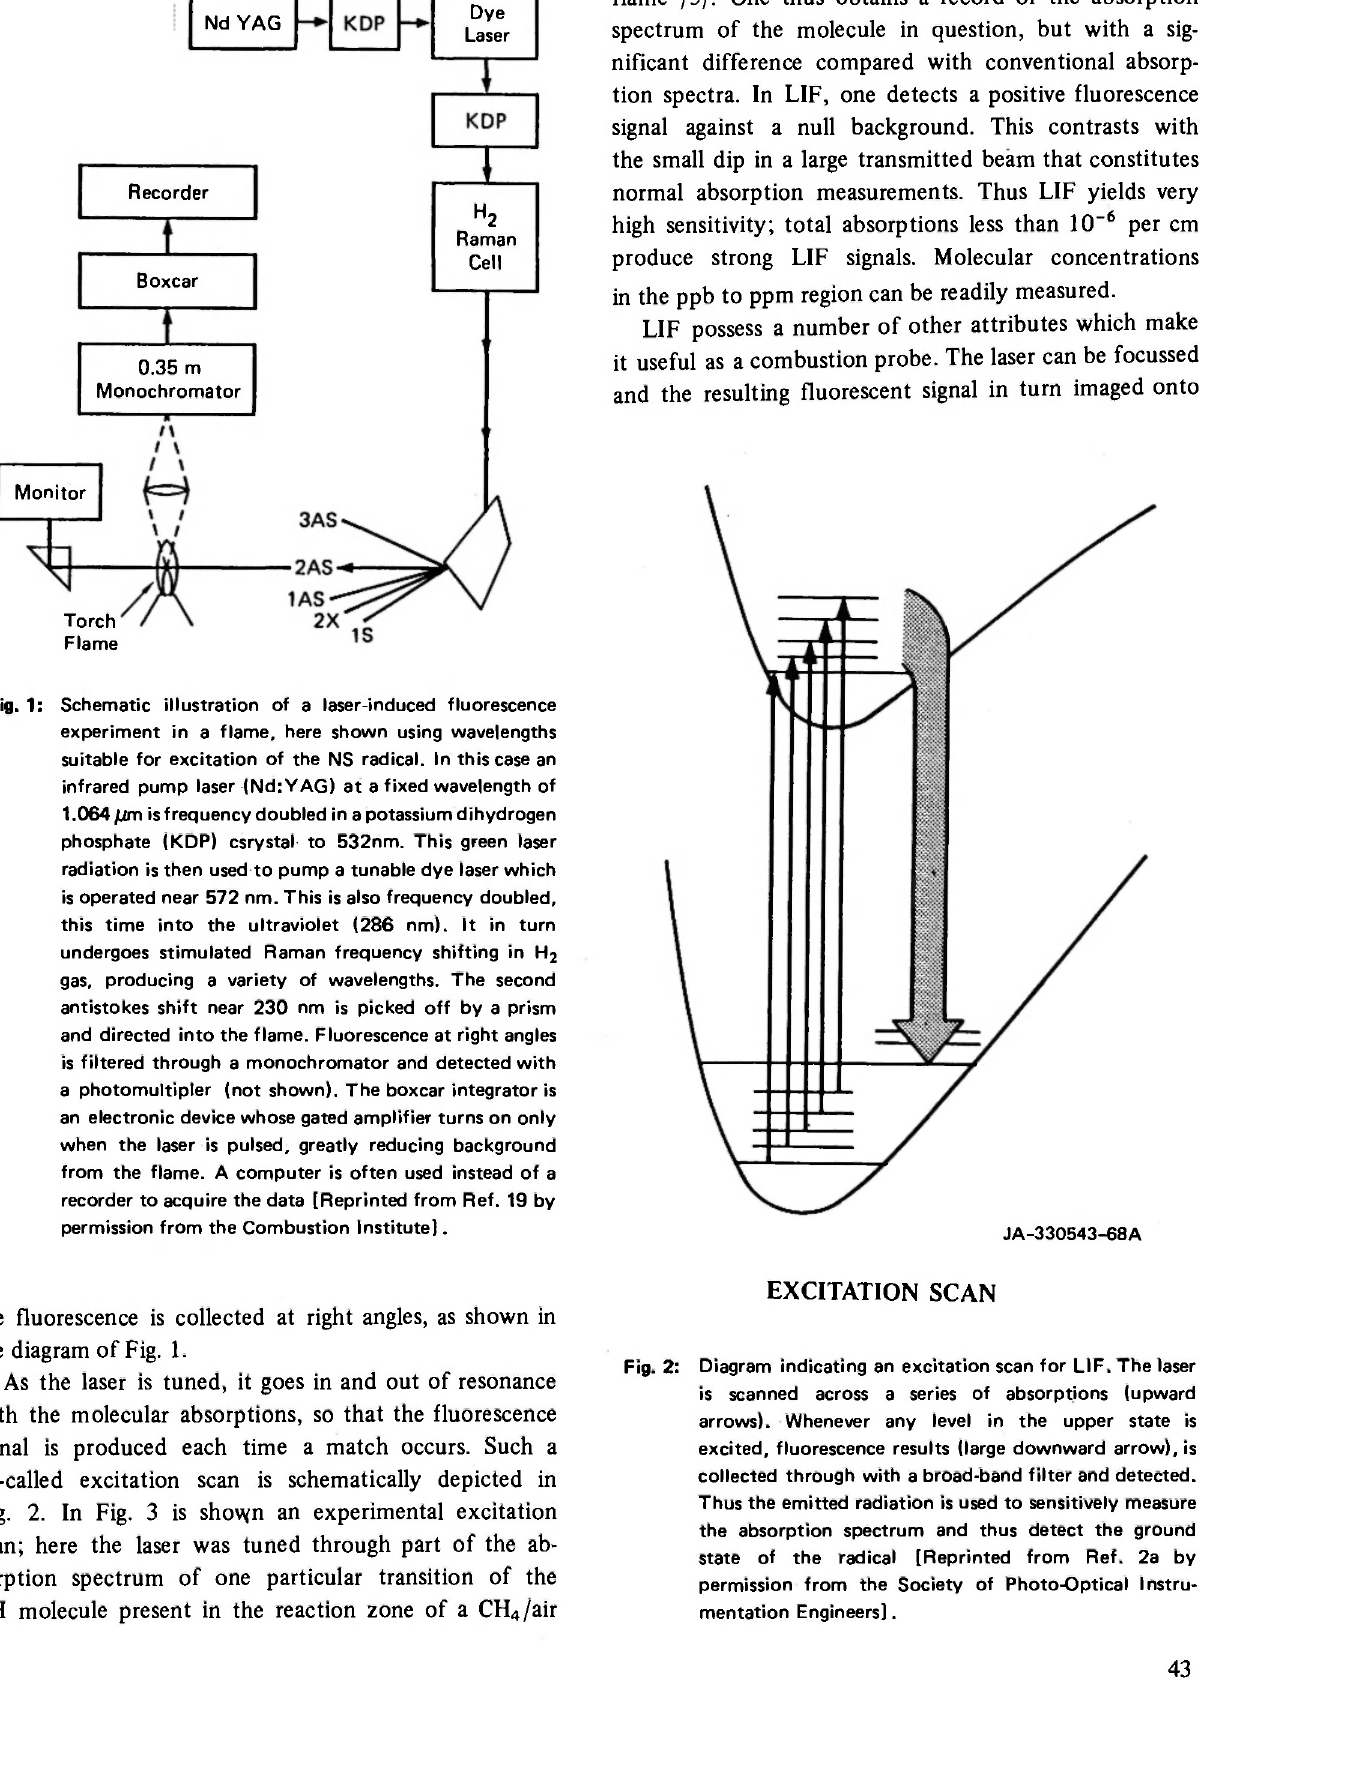
Fig. 1: Schematic illustration of a laser-induced fluorescence experiment in a flame, here shown using wavelengths suitable for excitation of the NS radical. In this case an infrared pump laser (Nd:YAG) at a fixed wavelength of 1.064 μτη is frequency doubled in a potassium dihydrogen phosphate (KDP) csrystal to 532nm. This green laser radiation is then used to pump a tunable dye laser which is operated near 572 nm. This is also frequency doubled, this time into the ultraviolet (286 nm). It in turn undergoes stimulated Raman frequency shifting in Hj gas, producing a variety of wavelengths. The second antistokes shift near 230 nm is picked off by a prism and directed into the flame. Fluorescence at right angles is filtered through a monochromator and detected with a photomultipler (not shown). The boxcar integrator is an electronic device whose gated amplifier turns on only when the laser is pulsed, greatly reducing background from the flame. A computer is often used instead of a recorder to acquire the data [Reprinted from Ref. 19 by permission from the Combustion Institute).